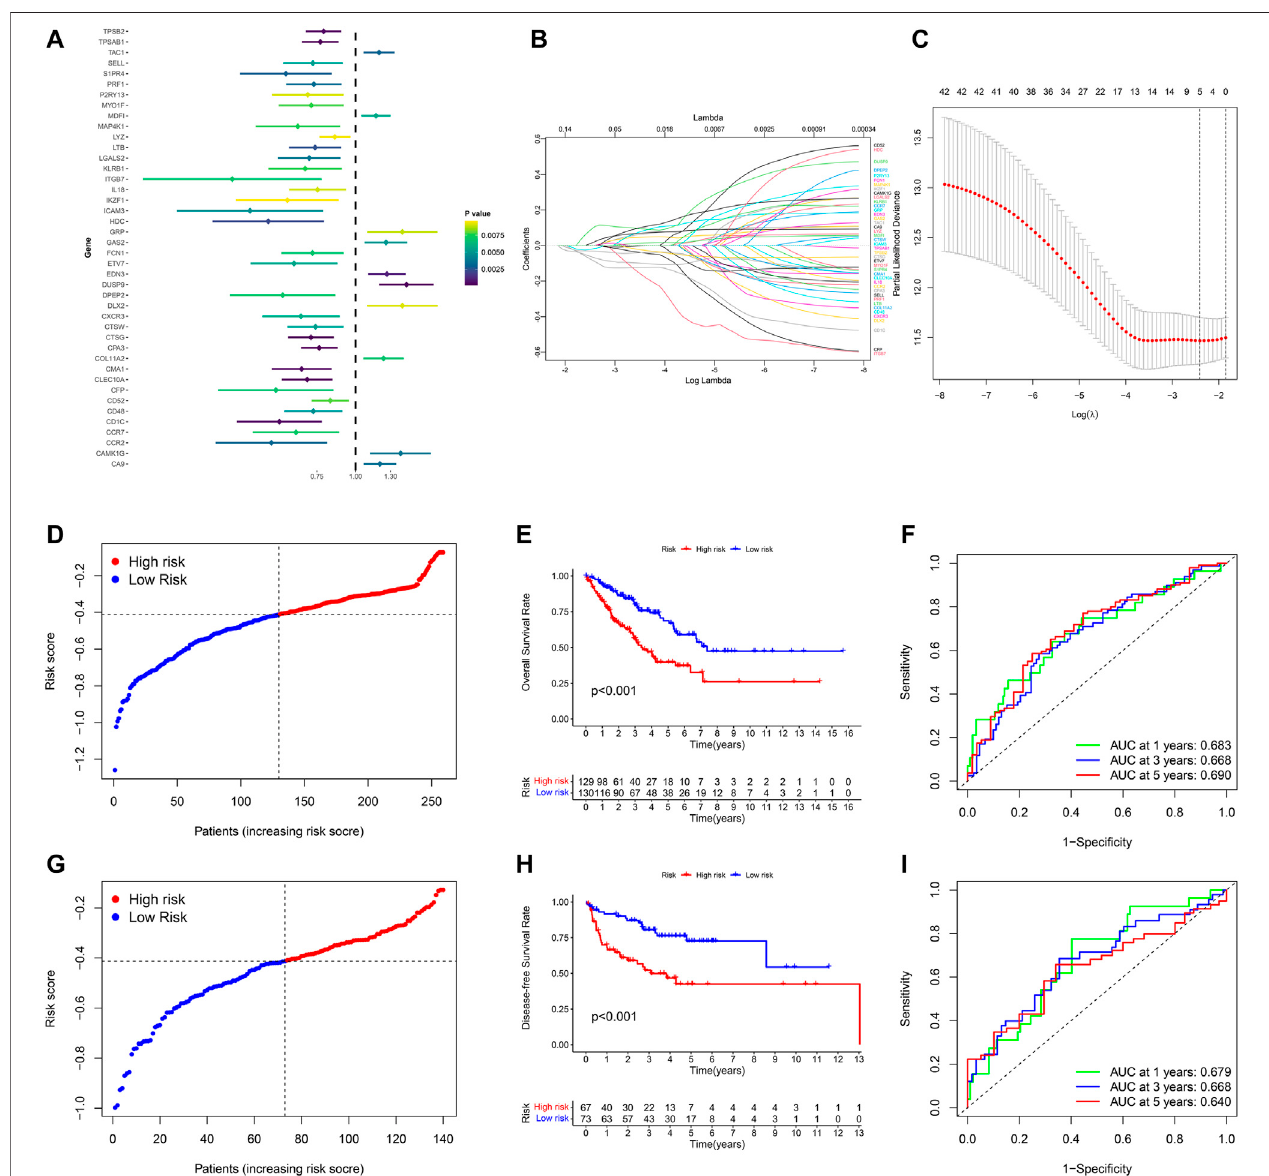
FIGURE 5 | Development and validation of the pyroptosis-related gene signature in STS. (A) Univariate COX regression analysis of DEGs between pyroptosis- related cluster one and cluster 2, and all 42 genes with p < 0.001. (B) LASSO regression analysis of 42 DEGs. (C) Cross validation method to select optimal genes. (D) Distribution of TCGA-SARC cohort based on the risk score. (E) OS curve of TCGA-SARC cohort in low-risk and high-risk groups. (F) Time-dependent ROC to evaluate the prognostic performance of the risk score in TCGA-cohort. G Distribution of GSE30929 cohort based on the risk score. (H) Disease-free survival (DFS) curve of GSE30929 cohort in low-risk and high-risk groups. (I) Time-dependent ROC to evaluate the prognostic performance of risk score in GSE30929